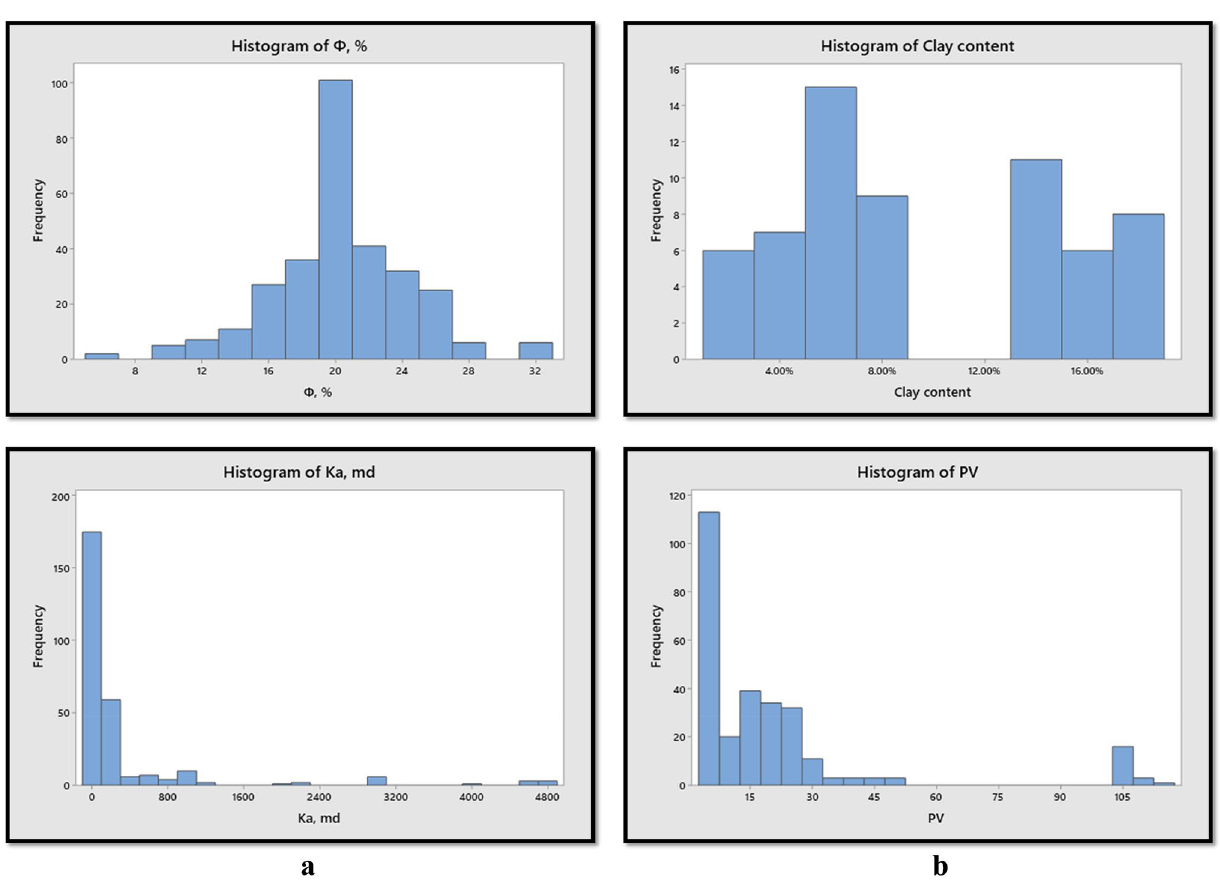
Fig. 1 a Histograms of porosity and permeability of the plugs from the literature. b Histograms of clay content and pore volume of the plugs from the